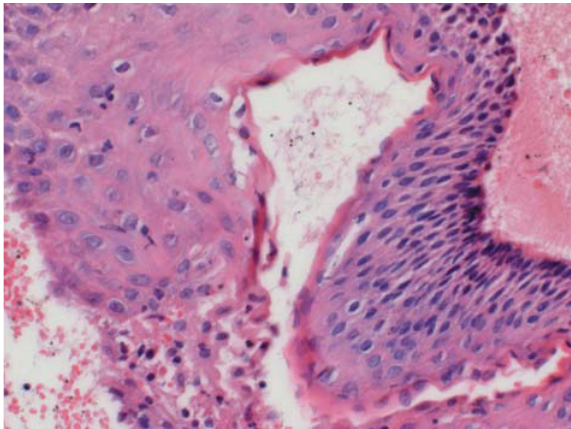
Figure 4- Photomicrograph of the lesion showing (cid:16)(cid:9)(cid:19)(cid:3)(cid:9)(cid:6)(cid:7)(cid:18)(cid:21)(cid:11)(cid:18)(cid:23)(cid:6)(cid:9)(cid:29)(cid:18)(cid:17)(cid:6)(cid:3)(cid:17)(cid:11)(cid:17)(cid:6)(cid:5)(cid:6)(cid:5)(cid:4)(cid:11)(cid:31)(cid:6)(cid:9)(cid:29)(cid:11)(cid:23)(cid:19)(cid:10)(cid:2)(cid:6)(cid:5)(cid:18)(cid:5)(cid:9)(cid:11)(cid:8)(cid:10)(cid:17)(cid:22)(cid:2)(cid:5)(cid:3)(cid:19)(cid:11)(cid:20)(cid:3)(cid:16)(cid:3)(cid:17)(cid:11) cell layer and parakeratin (hematoxylin and eosin, original